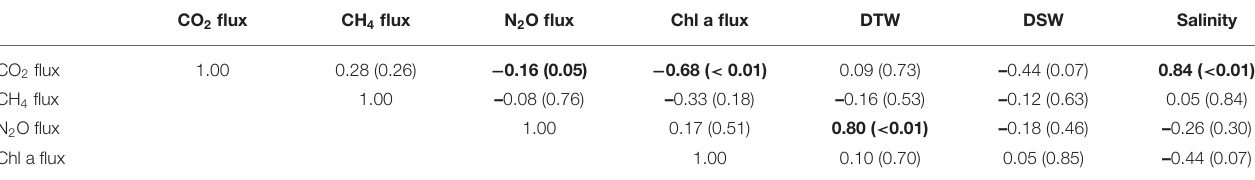
TABLE 2 | Pearson correlations between greenhouse gas fluxes, g dry oyster tissue (DTW) and g dry oyster shell (DSW), and salinity for O. edulis